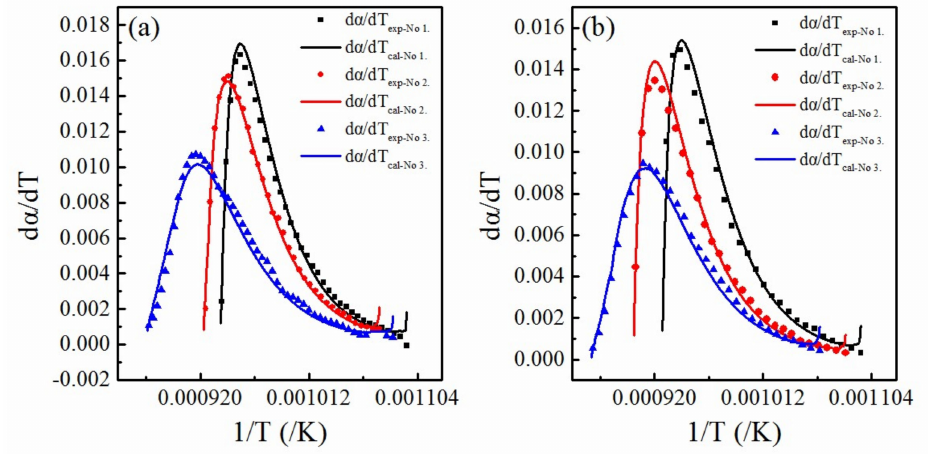
Figure 7. The relative error curves under di ff erent heating rate ( a ) The heating rate is 10 K / min; ( b ) The heating rate is 15 K / min.